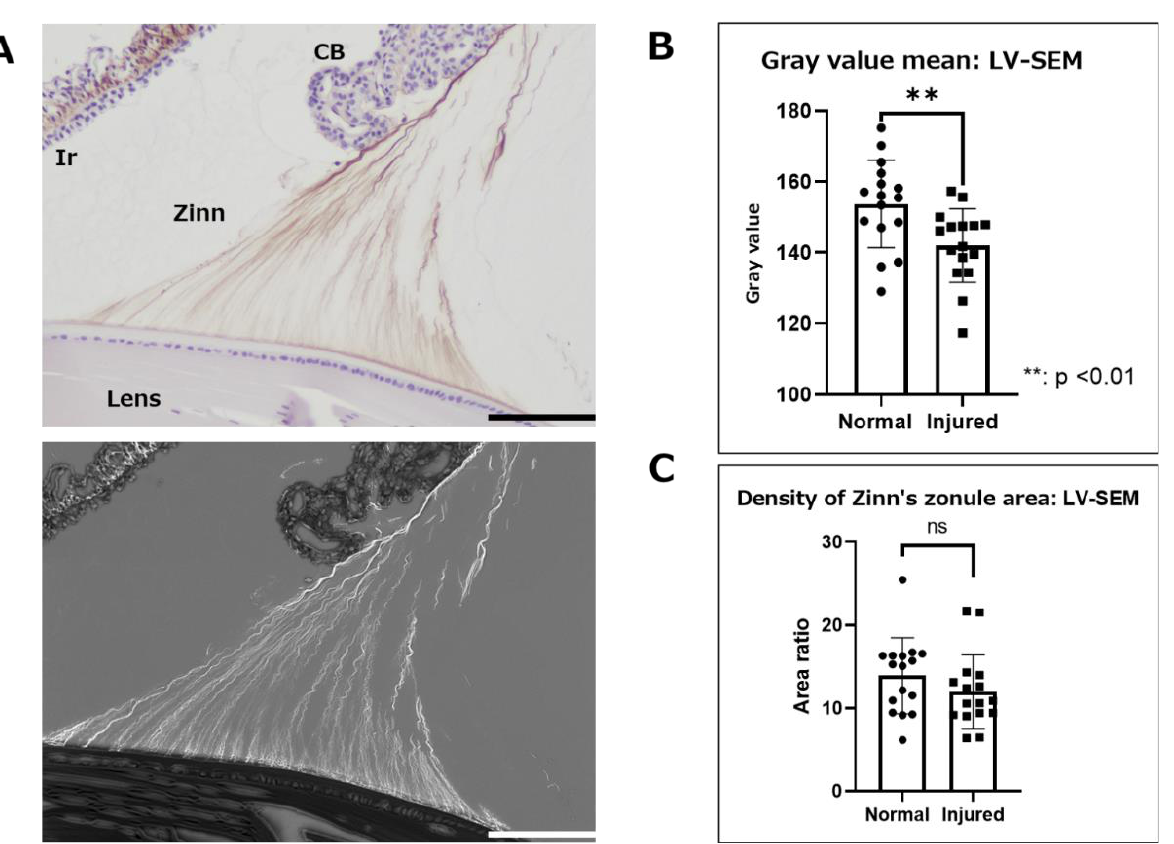
Figure 4. Immunohistochemical observation with LV-SEM analysis using paraffin-embedded speci- mens. Zinn’s zonules were labeled with anti-MAGP1 antibody and the heavy metal enhancement method was used to potentiate signals derived from DAB staining. Observations of Zinn’s zonule were made at low magnification (300 × ) to evaluate overall changes. ( A ) This image is in the normal group. The DAB-stained areas were clearly stained white by heavy metal staining in LV-SEM obser- vations. ( B ) Zinn’s zonule area and gray value, a measure of color density, were measured using the color range selection function of Adobe Photoshop. ( C ) The area enclosed by the lens capsule, the anterior and posterior branches of Zinn’s zonule, and the area occupied by Zinn’s zonule were also used to measure density. Four specimens were used for the normal and injured groups and two 5 µ m sections were made from each specimen. The total number of observation areas was 16. We observed Zinn’s zonule in two locations of each section. LV-SEM: low-vacuum scanning electron